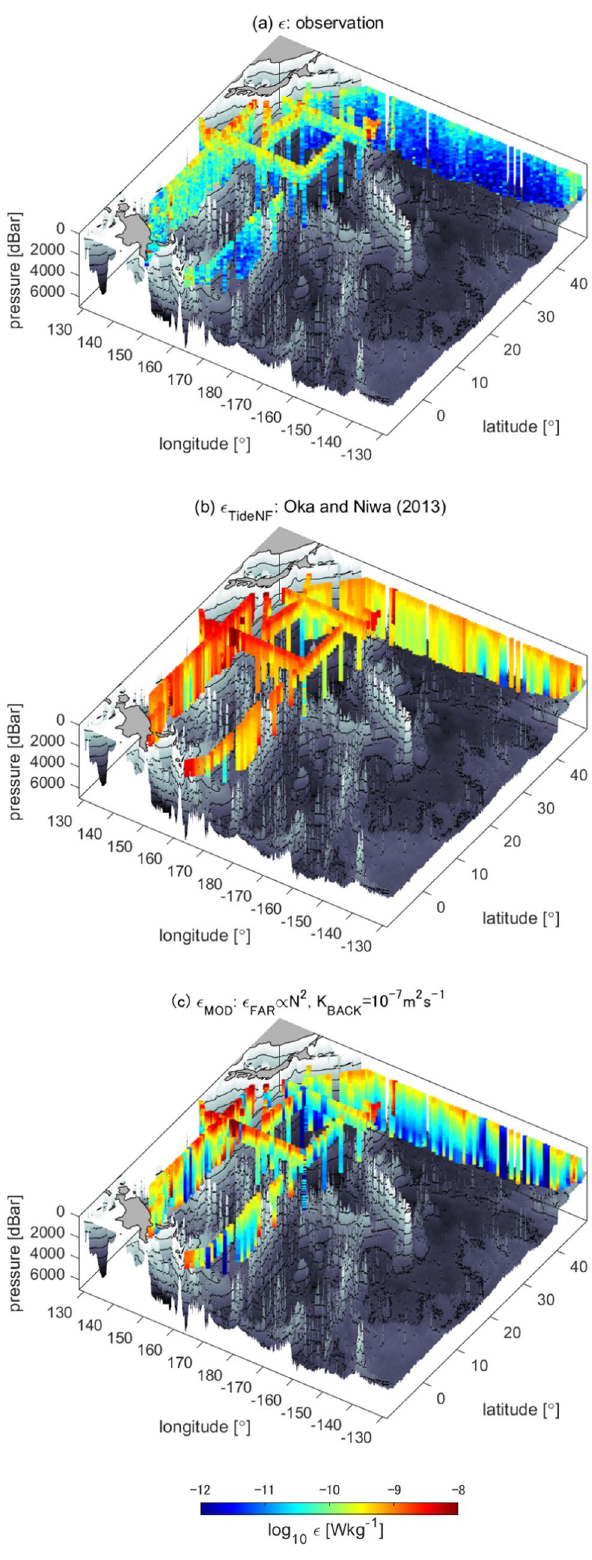
Figure 8. Comparison of 3-D ε distributions. Comparison of ε ( a ) Based on the CTD-attached thermistor observations, ( b ) based on the OGCM 2 , which reproduced the radio-carbon isotope ratio in the Pacific, and ( c ) based on the modified model, within which the far-field ε is proportional to the squared buoyancy frequency, N 2 , and the background value of ε is based on the observed minimum diapycnal diffusivity, K ρ = 10 –7 m 2 s −1 , to make the model distribution closer to the